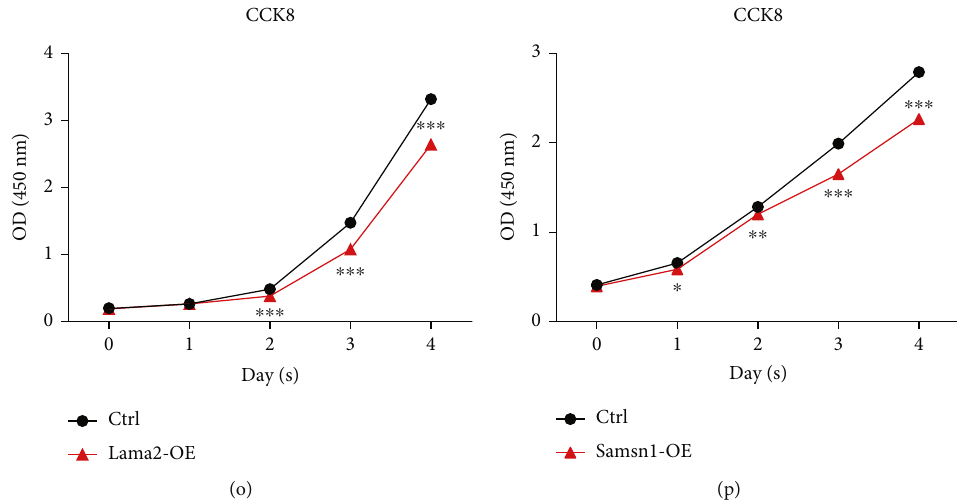
Figure 3: Lama2 activation or Samsn1 overexpression inhibits the proliferation of hippocampal NSCs. (a) Quanti fi cation of Lama2 mRNA level normalized to β -actin in the hippocampal NSCs which were transfected with di ff erent concentrations of Lama2 CRISPR SAM coactivated plasmid. (b) Quanti fi cation of Samsn1 mRNA level normalized to β -actin in the hippocampal NSCs which were infected by Samsn1 overexpression lentivirus. (c) The upper panel is the representative immunoblots of Samsn1 and β -actin after being infected by Samsn1 overexpression lentivirus; the lower panel is the quanti fi cation of Samsn1 protein level normalized to β -actin. (d) The upper panel is the representative immunoblots of Lama2 and β -actin after being infected by Lama2 CRISPR SAM coactivated plasmid; the lower panel is the quanti fi cation of Lama2 protein level normalized to β -actin. (e, f) Representative EdU-staining in primary hippocampal NSCs. Bar = 20 μ m . (g, h) Quanti fi cation of EdU-positive cells normalized to Hoechst. (i – k) Representative cell cycle distribution analyzed by fl ow cytometry in primary hippocampal NSCs after Lama2 activation (i, j) and quanti fi cation for NSCs in the di ff erent stages of the cell cycle (k). (l – n) Representative cell cycle distribution analyzed by fl ow cytometry in primary hippocampal NSCs after Samsn1 overexpression (l, m) and quanti fi cation for NSCs in the di ff erent stages of the cell cycle (n). (o, p) CCK-8 assay in primary hippocampal NSCs 0, 1, 2, 3, 4 days after plasmid transfection or virus infection. Error bars represent the mean ± SEM . n = 3 . ∗ P < 0 : 05 , ∗∗ P < 0 : 01 , ∗∗∗ P < 0 : 001 . Abbreviations: Ctrl: control; Lama2-OE: Lama2-overexpression; Samsn1-OE: